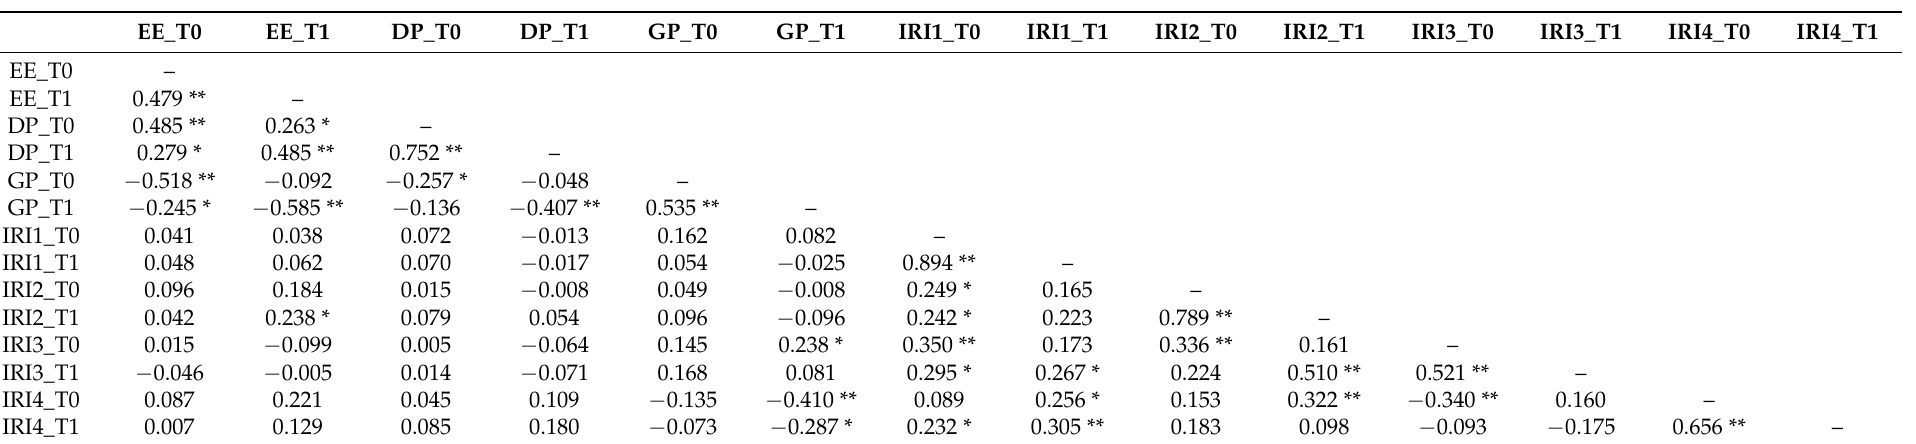
Table A5. Association between Maslach Burnout Inventory and Interpersonal Reactivity